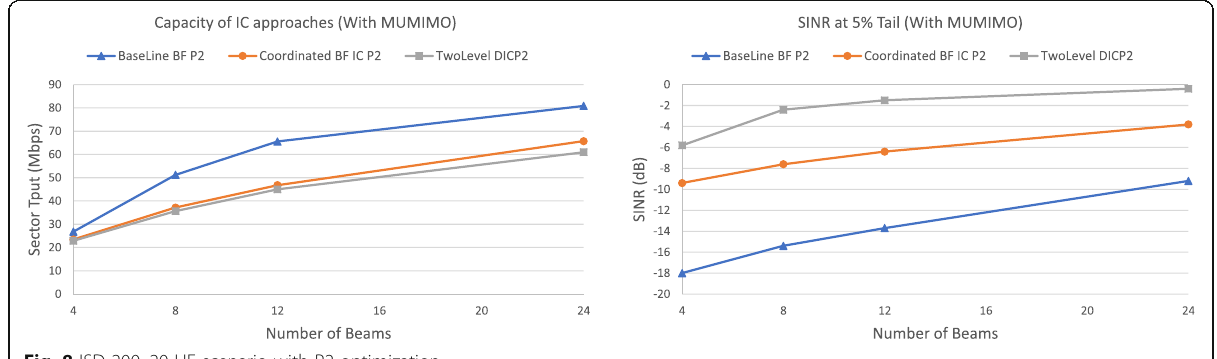
Fig. 8 ISD 200, 20 UE scenario with P2